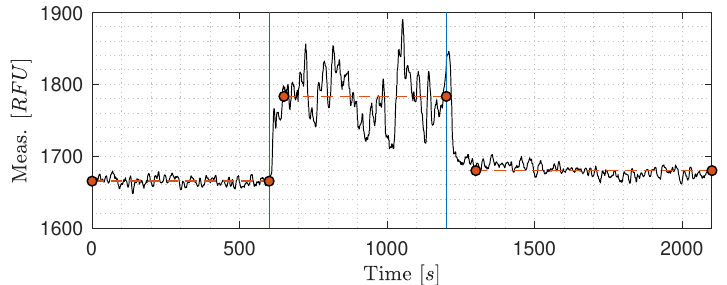
Figure 10. Gas bubbles’ influence on the OiW